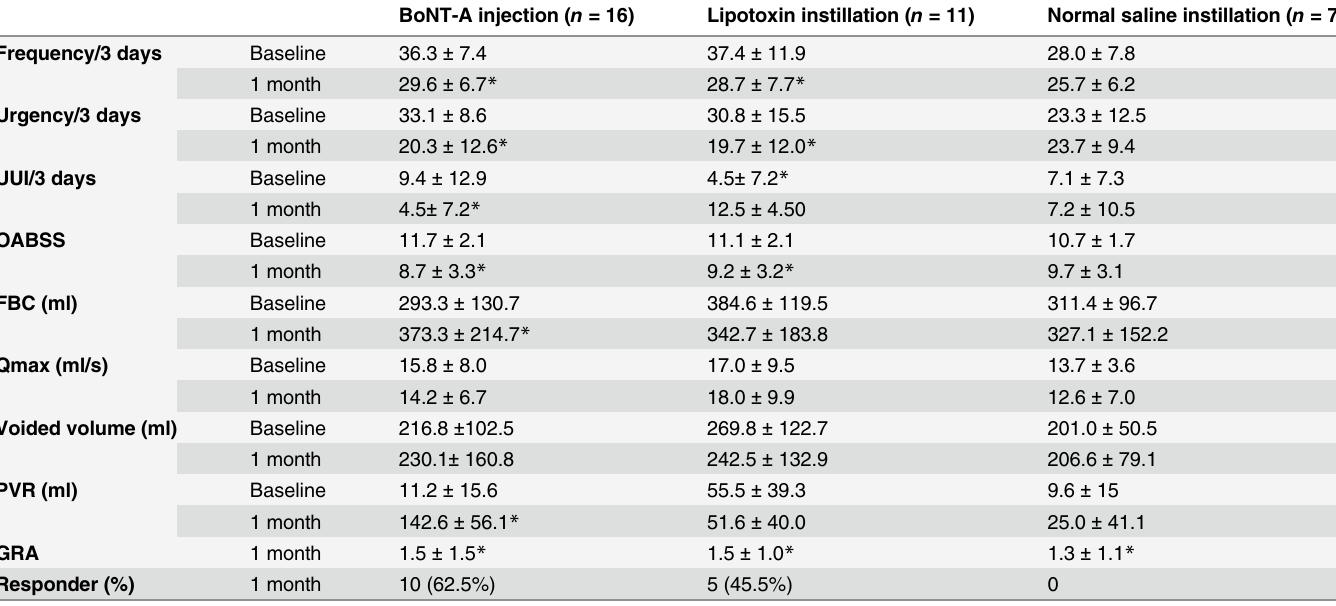
* : Signi fi cant difference between baseline and one month after treatment. Data are expressed as means ± standard